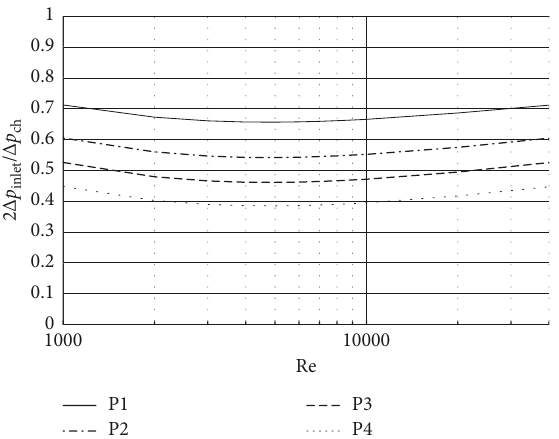
Figure 13: Characteristic dependence of friction factor f from relative length of corrugated field X .